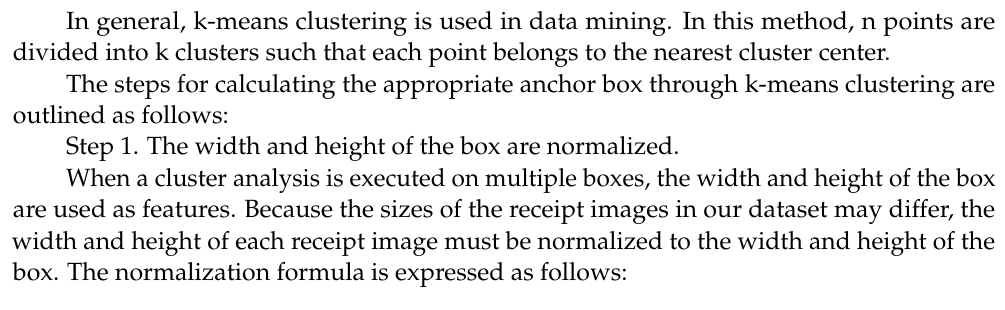
Figure 6. Identifying a real object by using an anchor box.